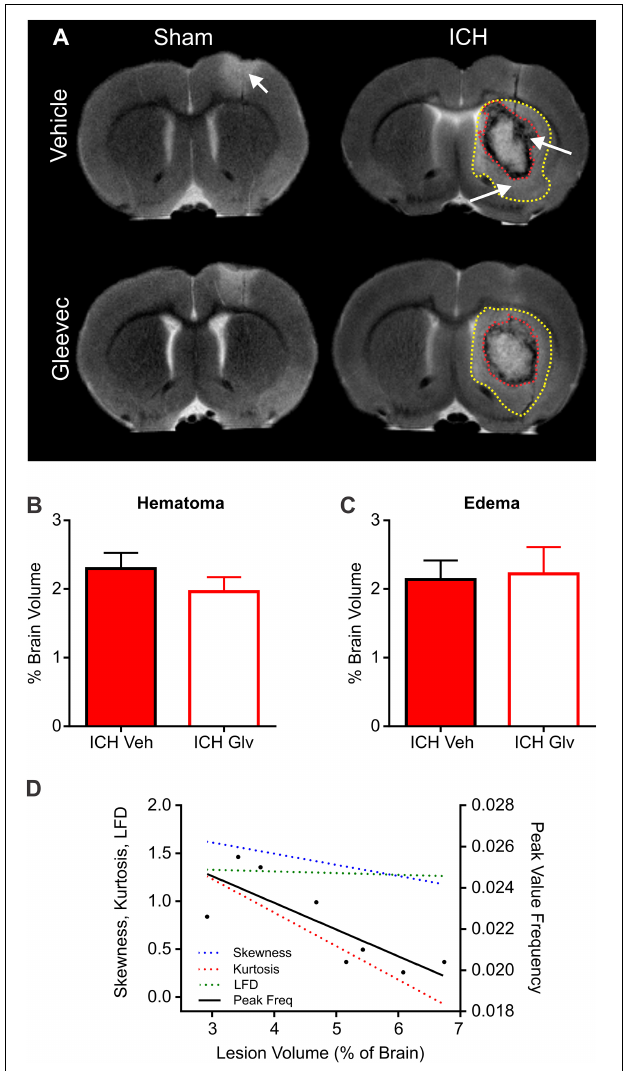
FIGURE 7 | Lesion and hemorrhage volumes were not modified by Gleevec treatment 24 h after ICH. (A) Representative MR images from Vehicle and Gleevec treatment rats. Shams exhibited cortical edema (white arrow) at the site of needle insertion. In ICH animals there were hypo- and hyperintense regions visible in the basal ganglia, consistent with blood (red dotted line) and edema (yellow dotted line), respectively (white arrows). (B) Subcortical hematoma volumes were not significantly altered between shams and Gleevec treated rats. (C) Volume of subcortical edema volumes was not significantly different following Gleevec treatment. (D) Correlations of total ICH lesion (blood + edema) volumes compared to ipsilateral fractal properties of ICH vehicle treated rat’s revealed significant correlations. The lesion volume was strongly correlated to fractal skewness ( R 2 = 0.6725, p = 0.0127), kurtosis ( R 2 = 0.6665, p = 0.0134), and peak frequency ( R 2 = 0.6290, p = 0.0189), but not for LFD ( R 2 = 0.1194, p = 0.4019). See Table 1 for additional